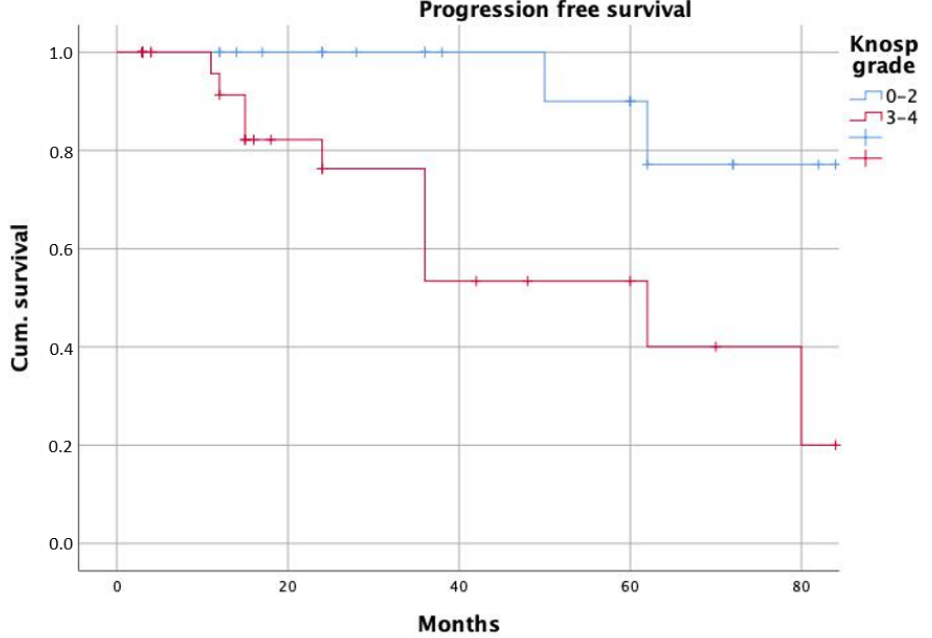
Figure 3. Progression-free survival according to Knosp grades. Table 3. Univariate and multivariable analyses of factors which resulted in incomplete resection and tumor remnants in intraoperative